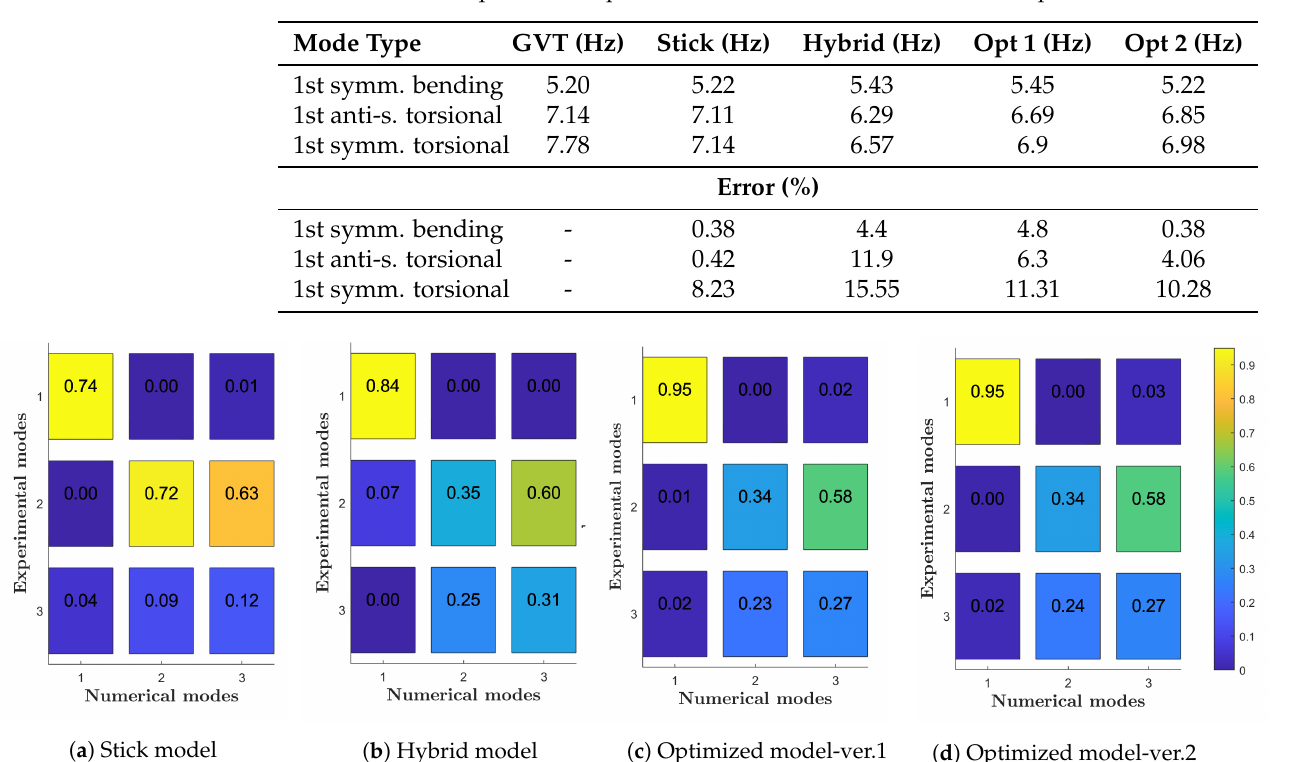
Table 9. Natural frequencies comparison. The anti-flutter mass is in forward position.